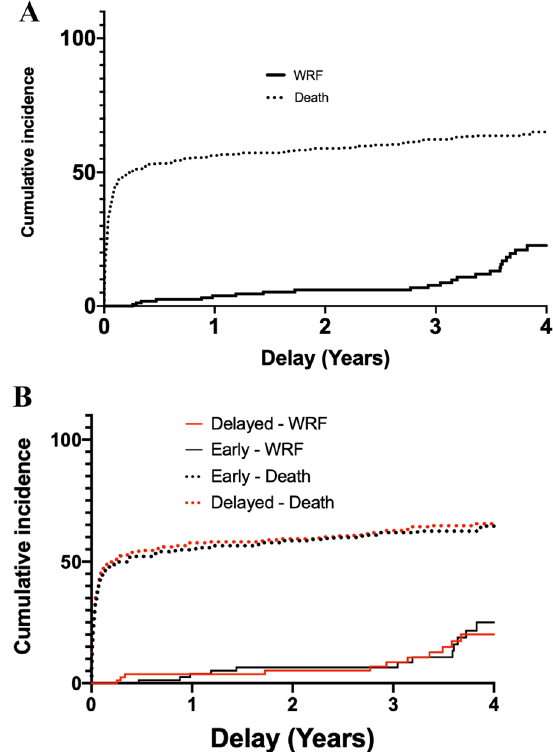
Fig. 3 Cumulative incidence of WRF and death. Panel A shows cumulative incidence of WRF from D90 to end of extended follow‑up for all study participants Panel B shows cumulative incidence of WRF and death from D90 to end of extended follow‑up according to RRT initiation strategy group. WRF Worsening renal function (Defined for non‑CKD patients at baseline by the occurrence of CKD and for CKD patients at baseline by the progression from a stage 3 to a stage 4 or 5)